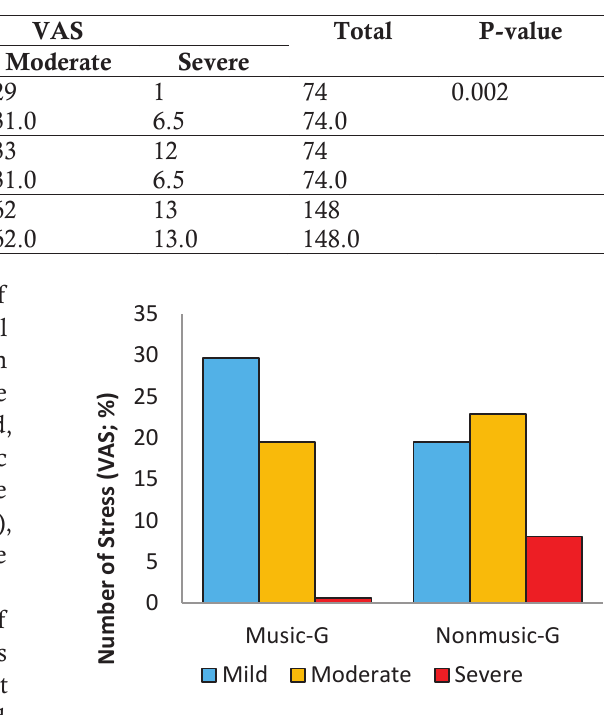
Figure 1. Student’s Stress Profile in